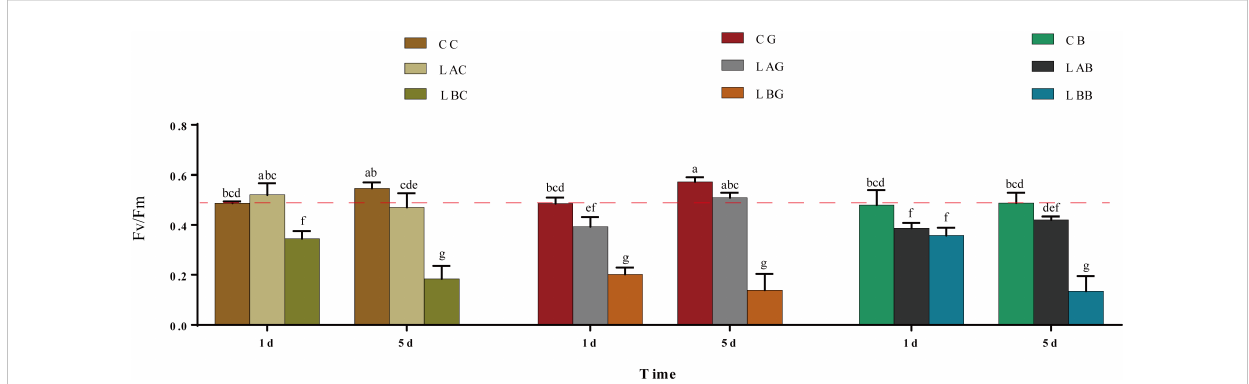
FIGURE 7 The maximum quantum yield of photosystem II (Fv/Fm) in B fuscopurpurea under different culture conditions. Data was Mean ± SD (n = 9). Different letters indicated signi fi cant differences ( p < 0.05). The red dotted line indicates the level in the CC (100% seawater)